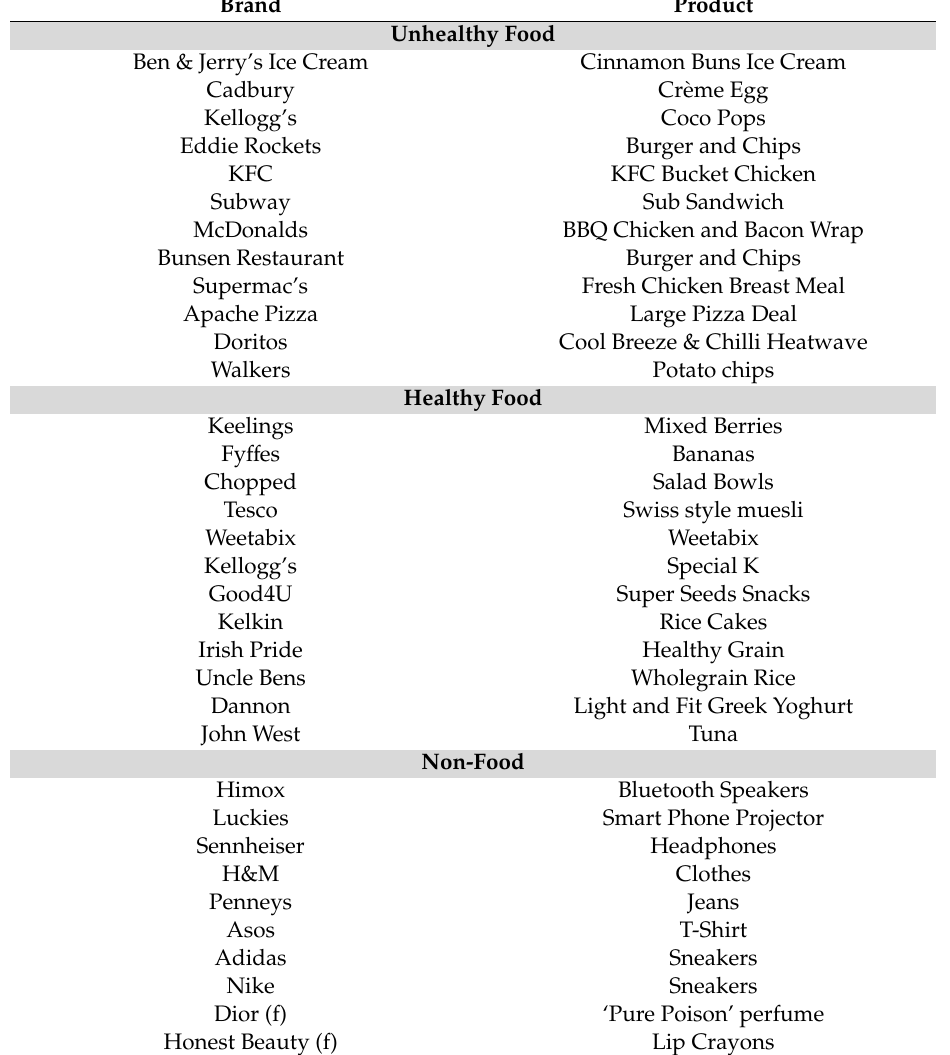
Table 2. Brands and products shown in target